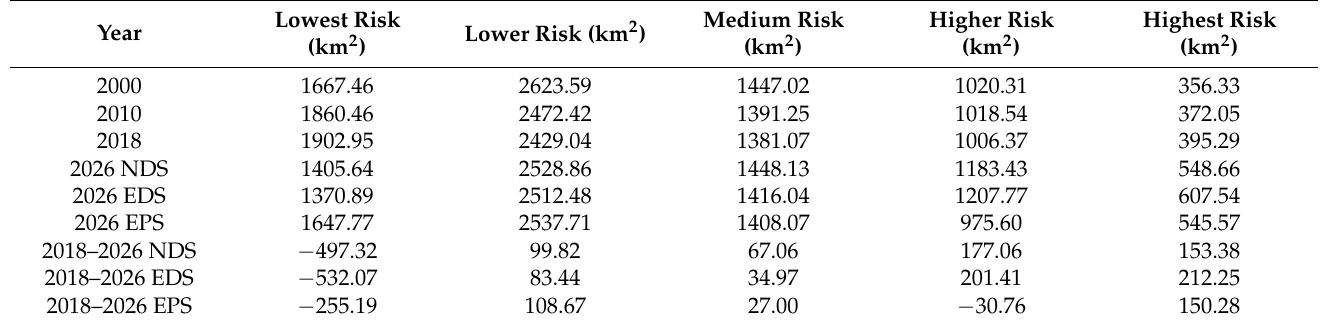
Table 6. Area changes of different levels of ecological risk in the